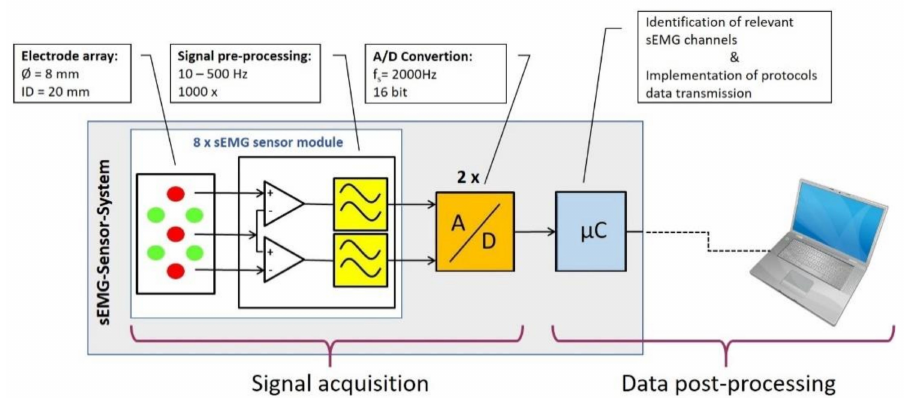
Figure 2. Block diagram of the sEMG sensor system. Integral part of the sensor system are the eight sEMG sensor modules which comprise 16 active sEMG electrodes with integrated preprocessing of the signals, two A / D converters and a microcontroller which is used to identify the relevant sEMG signals and implement the data transmission protocols.